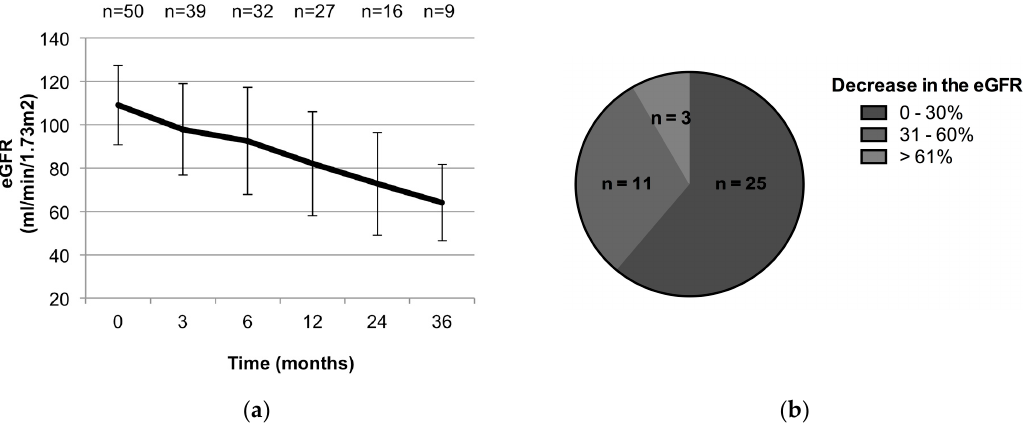
Figure 5. Changes in renal function. ( a ) Chronological changes in estimated glomerular filtration rate (eGFR) after administration of tacrolimus. ( b ) Decrease in eGFR during observation period (n =